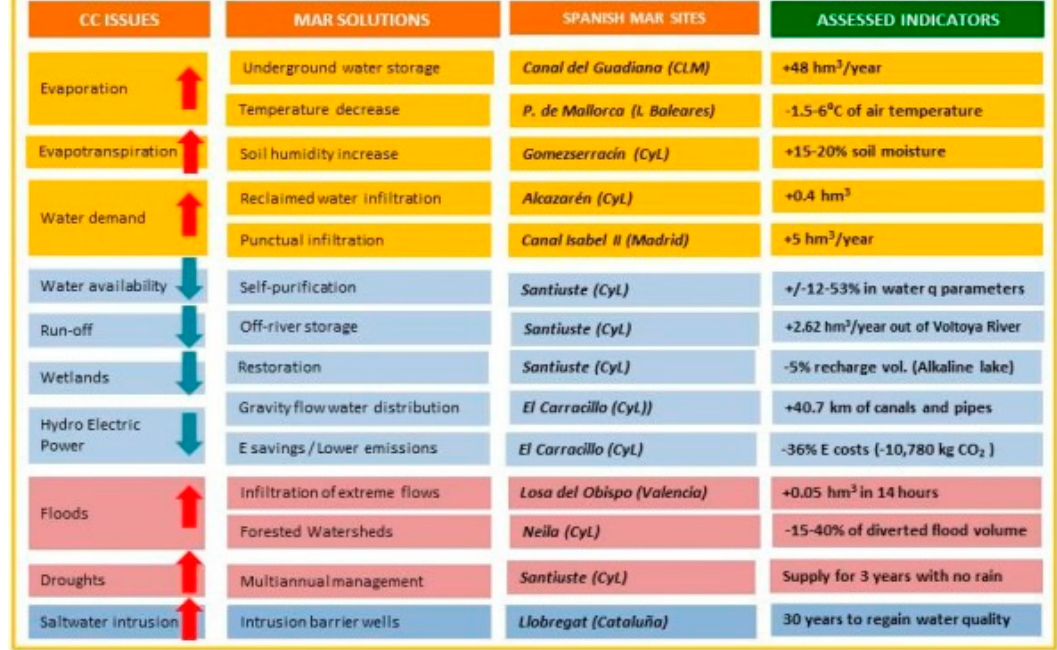
Figure 13. Relations between CC impacts and MAR solutions with their site locations and indicators of positive achievements.